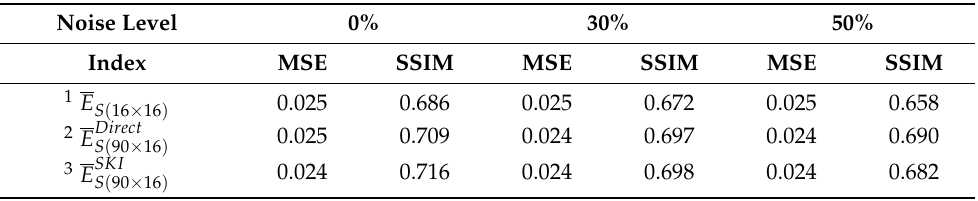
Figure 5. Changing curves of MSE and SSIM versus NVRA under different noise levels: ( a ) MSE; ( b ) SSIM.